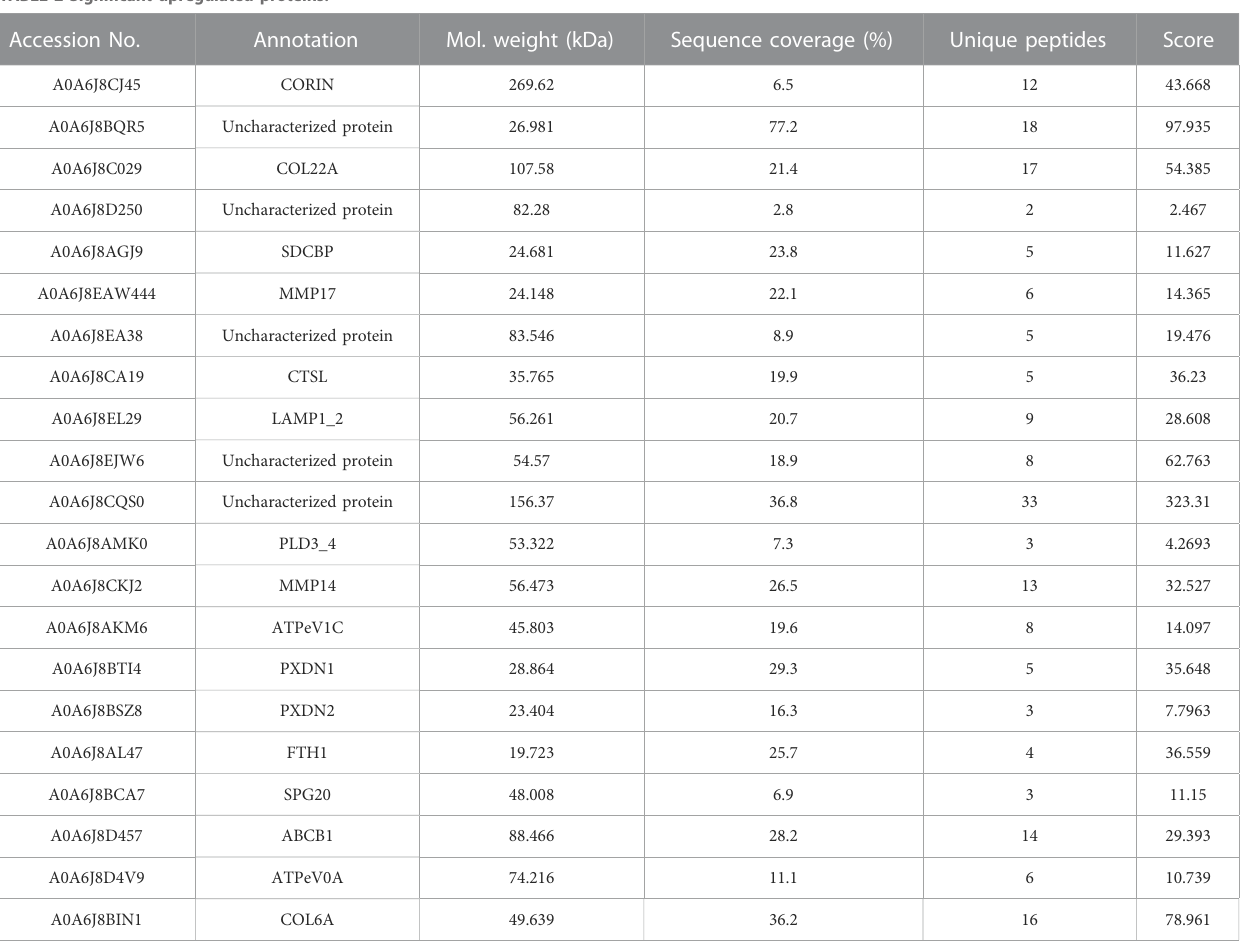
TABLE 2 Signi fi cant upregulated proteins. Accession No.